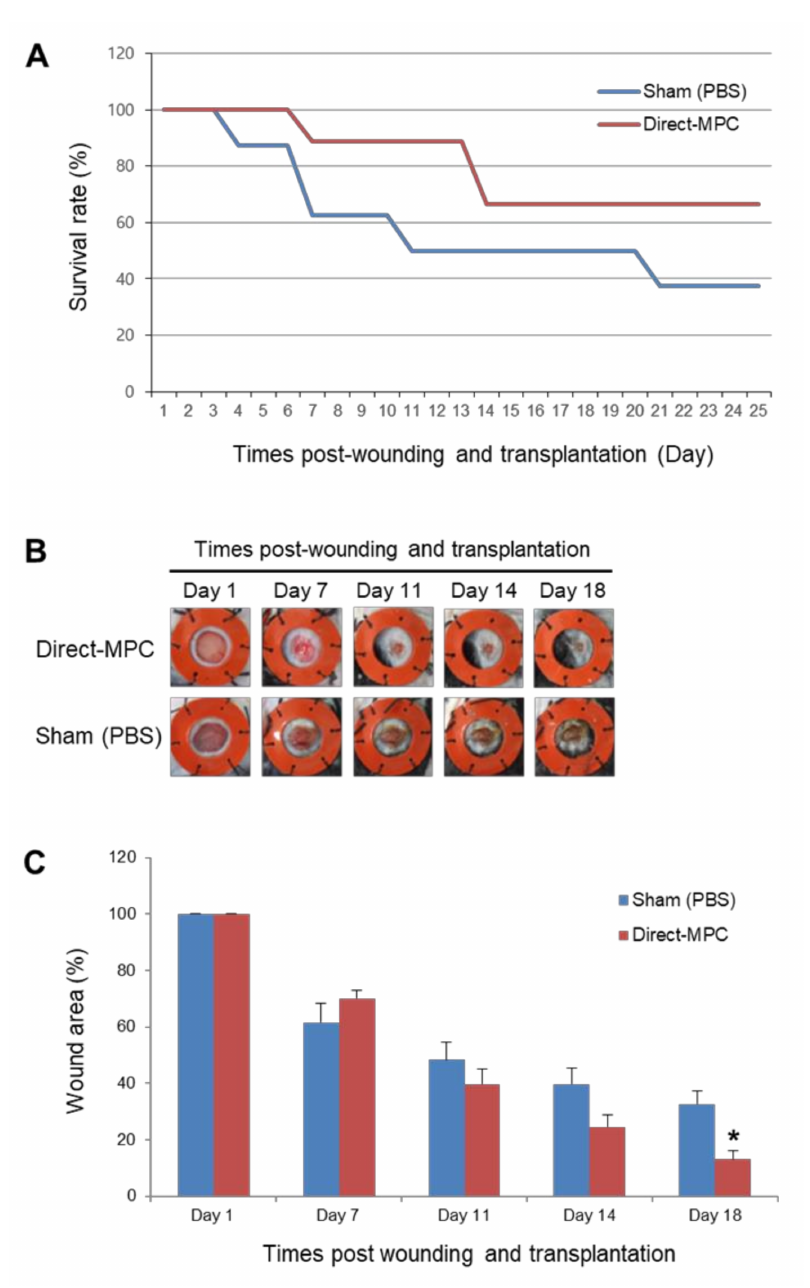
Figure 3. Effects of hPSC-Direct-MPCs on survival and in vivo wound closure in a streptozotocin (STZ)-induced diabetic mouse model. ( A ) Survival rate of both groups of MPCs in STZ-diabetic mice. Sham (PBS) group, n = 8; Direct-MPC group, n = 9. ( B ) Representative photographs of the wound splinting model established with STZ-diabetic mice after transplantation of PBS (sham control) and CHA-SCNT-hPSC-18-Direct-MPCs on days 1, 7, 11, 14, and 18. ( C ) Wound measurement of the STZ-diabetic mice in each group. Sham (PBS) group, n = 4; Direct-MPC group, n = 6. * p <